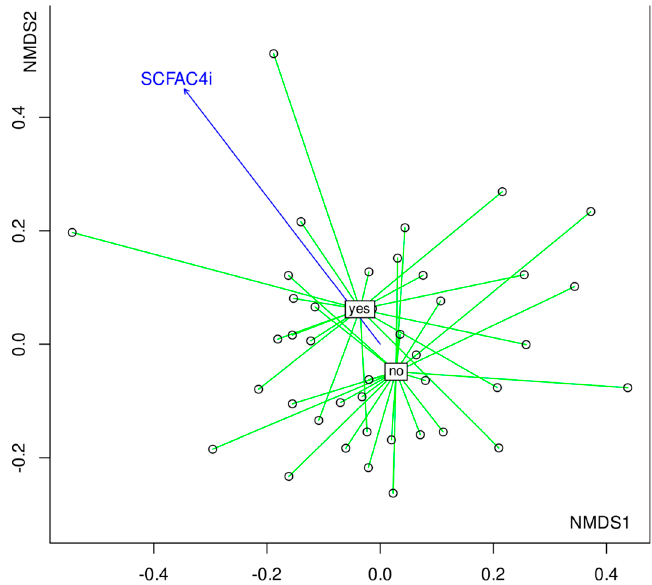
Figure 5. NMDS plot of bacterial communities where samples are grouped into two significantly different groups—presence/absence of gastrointestinal complaints with the arrow representing increasing concentration of isobutyric acid in the stool. Yes—the presence of gastro-intestinal symp- toms; no—the lack of gastro-intestinal symptoms. The blue arrow represents direction of increasing concentration of SCFAC4i.